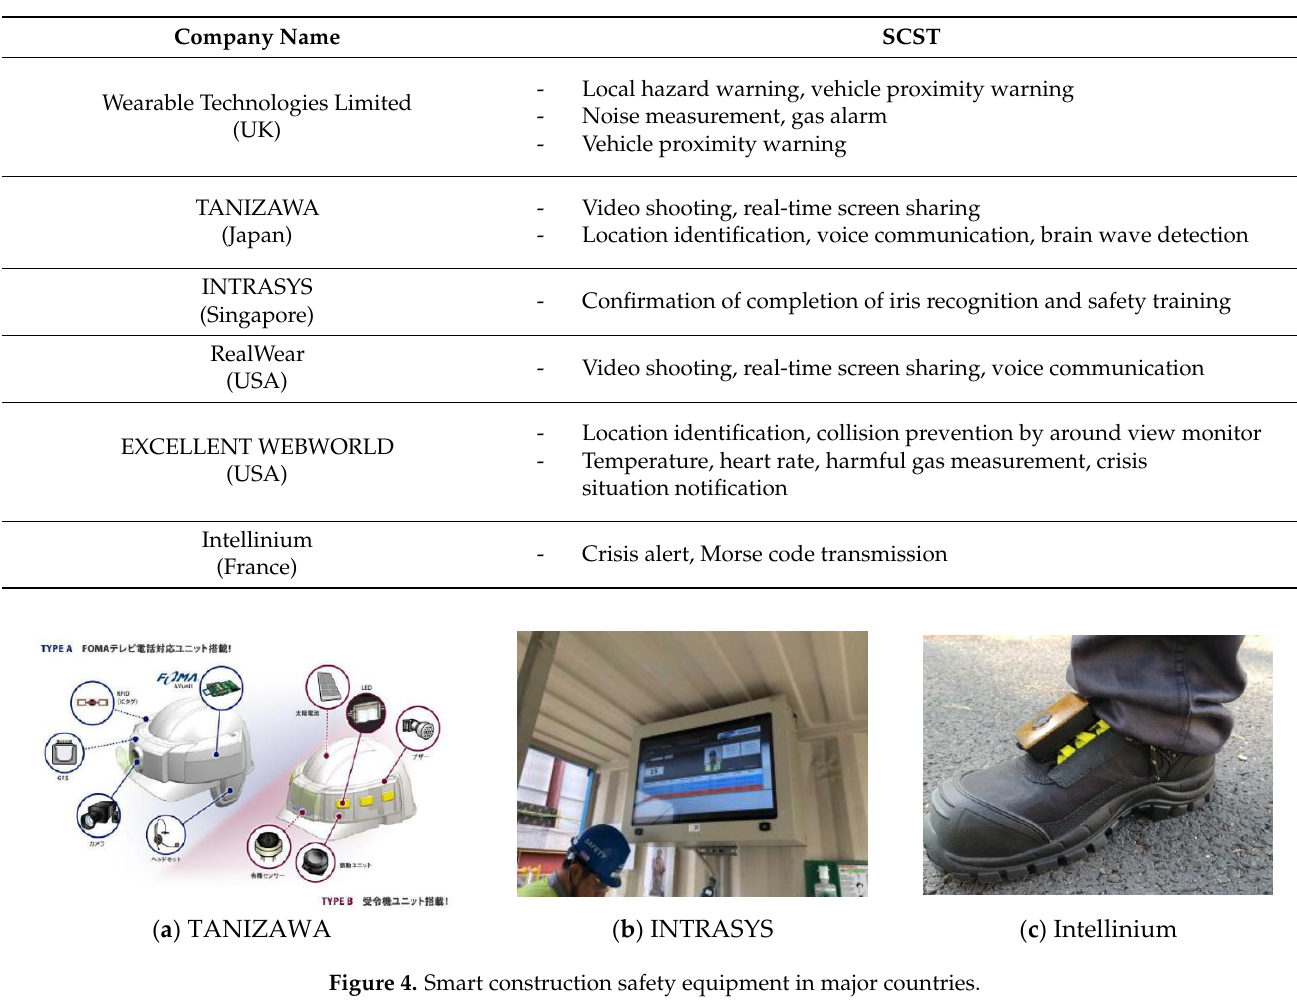
Table 1. Smart construction safety technology (SCST) companies and equipment in various countries.